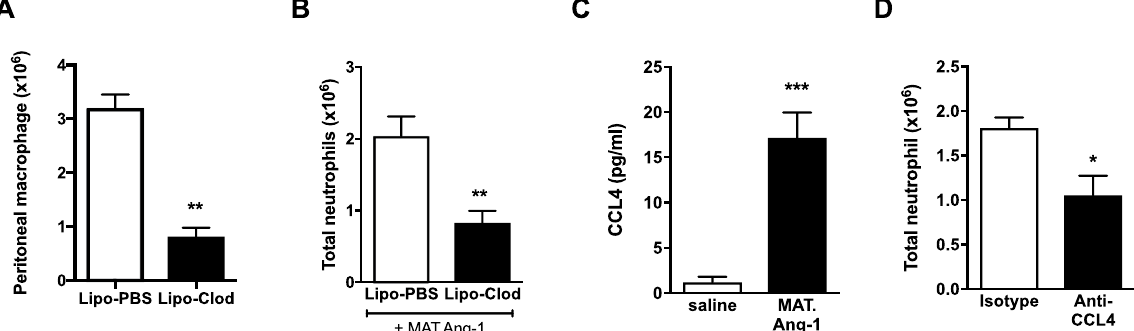
Figure 4. MAT.Ang-1 induced neutrophil migration after depletion of peritoneal macrophages. ( A ) C57/ Bl6 mice were administered with 250 µ l control or clodronate liposomes i.p. After 48 h, peritoneal lavage was performed and the total monocyte/macrophage count was calculated using total and differential cell counts. ( B ) Liposomes were administered as above 48 h prior to injection of MAT.Ang-1 (33 µ g/mouse i.p.). After 4 h, peritoneal lavage was performed and the total neutrophil count was calculated using total and differential cell counts. ( C ) CCL4 levels in peritoneal lavage fluid were measured by cytometric bead array 4 h after MAT.Ang-1 administration ( D ) Rat anti-mouse CCL4 (MAB451) or rat IgG2a (both 50 µ g/ml) were administered together with MAT.Ang-1 and neutrophil levels in lavage fluid measured after 4 h. Results are expressed as mean ± SEM (n = 3–5 mice). Statistical significance was analysed using an unpaired t-test. * P < 0.05, ** P < 0.01, *** P <